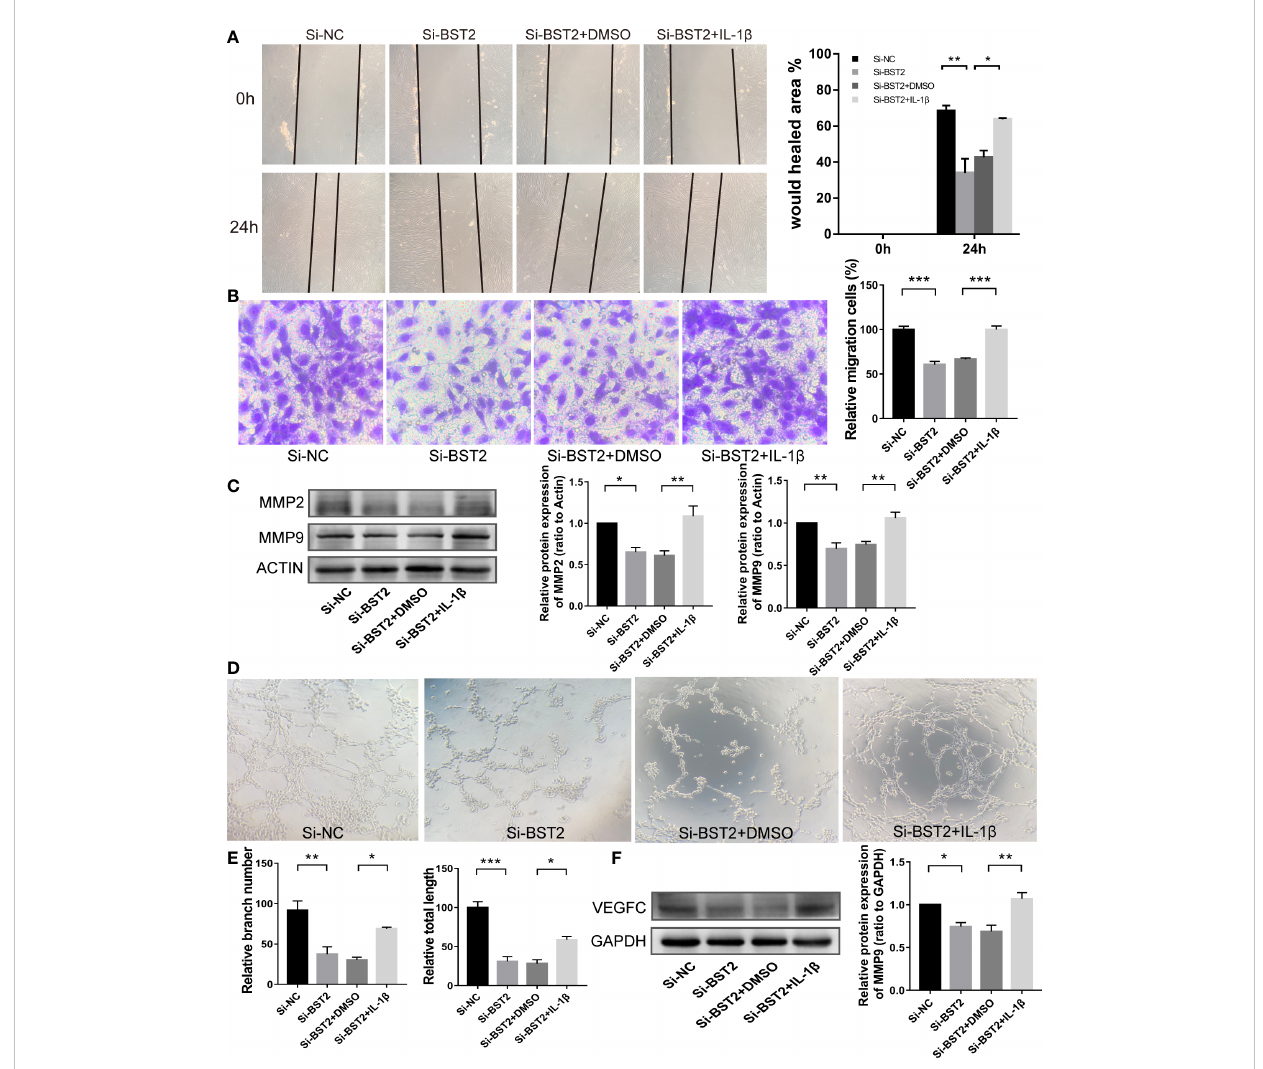
FIGURE 8 BST2 promoted migration and lymphangiogenesis of EESCs via the NF- k B signaling pathway. (A, B) , The wound healing assays (A) and the transwell assay (B) were performed to measure the cell migration ability of EESCs after transfection with Si-BST2 and/or IL-1 b . (C) , The western blot analysis was used to examine the migration-related protein after transfection with Si-BST2 and/or IL-1 b . (D, E) , The tube formation assay was conducted to check the tube formation ability with the CM of EESCs with Si-BST2 and/or IL-1 b on HLECs. (F) , The western blot analysis was used to measure the VEGFC after transfection with Si-BST2 and/or IL-1 b . *p < 0.05; **p < 0.01; ***p <